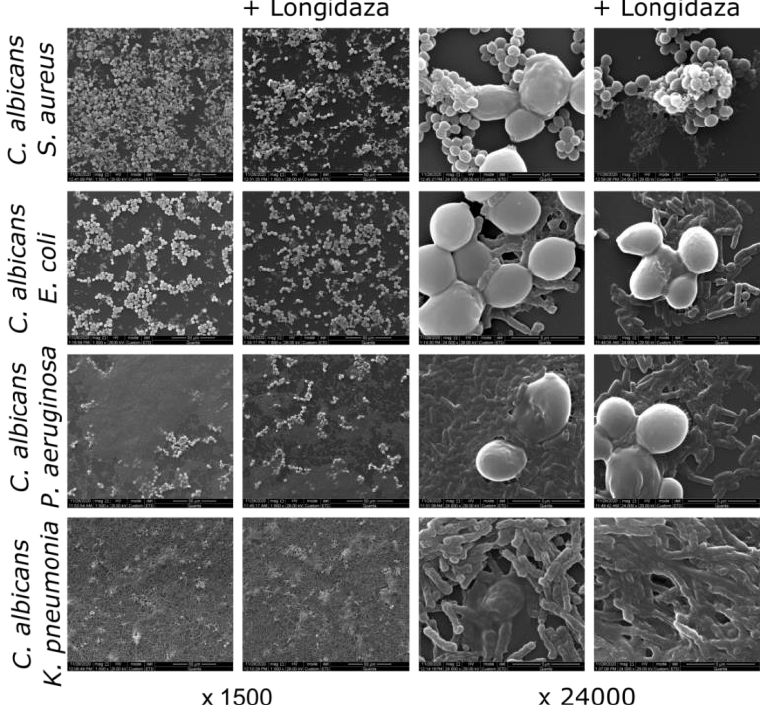
Figure 4. The effect of Longidaza ® on fungal – bacterial biofilms. Forty-eight-h-old fungal – bacterial biofilms were washed and incubated 24 h in fresh BM broth supplemented with 750 IU of Longidaza ® as indicated and analyzed with scanning electron microscopy.